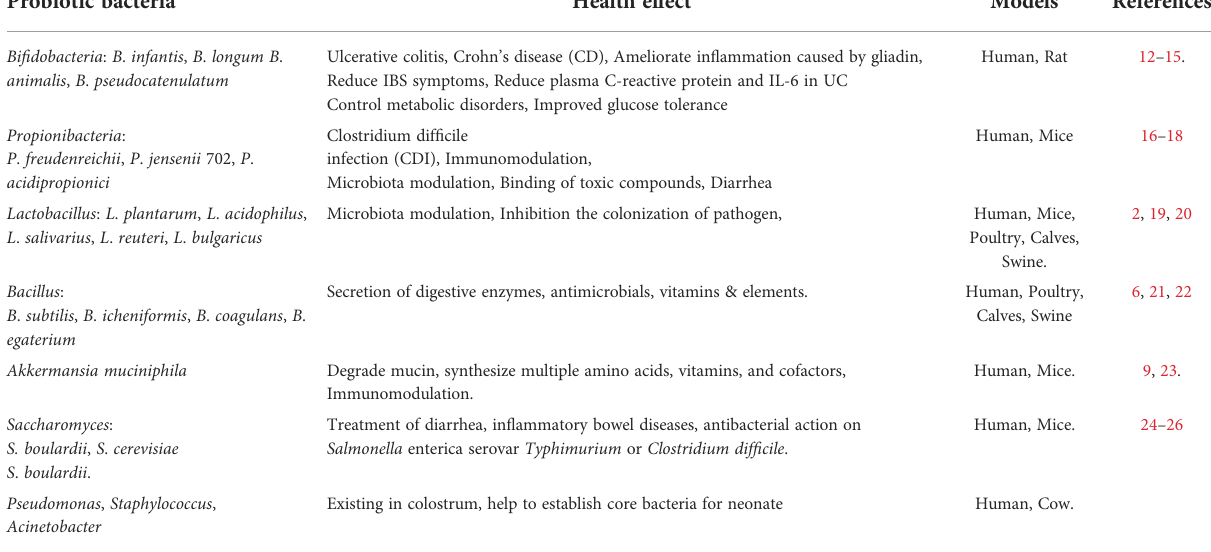
TABLE 1 Examples of bene fi cial effects of probiotics on humans and animal